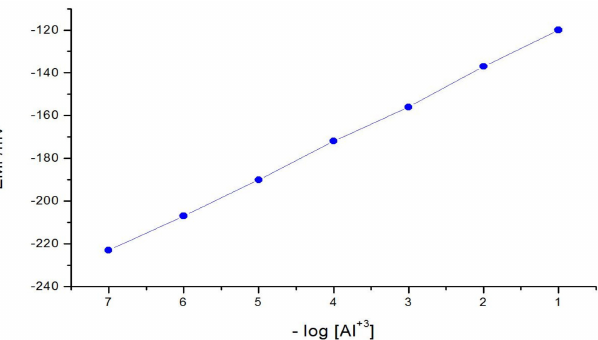
Figure 1. The curve of calibration of the developed Al(III) electrode over the concentration scope 10 − 7 –10 − 1 M.